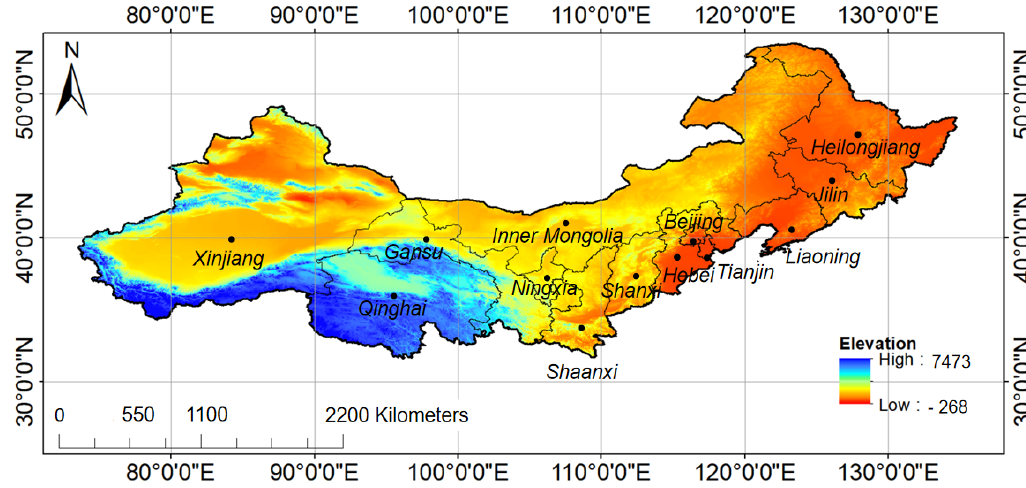
Figure 1. Study area and